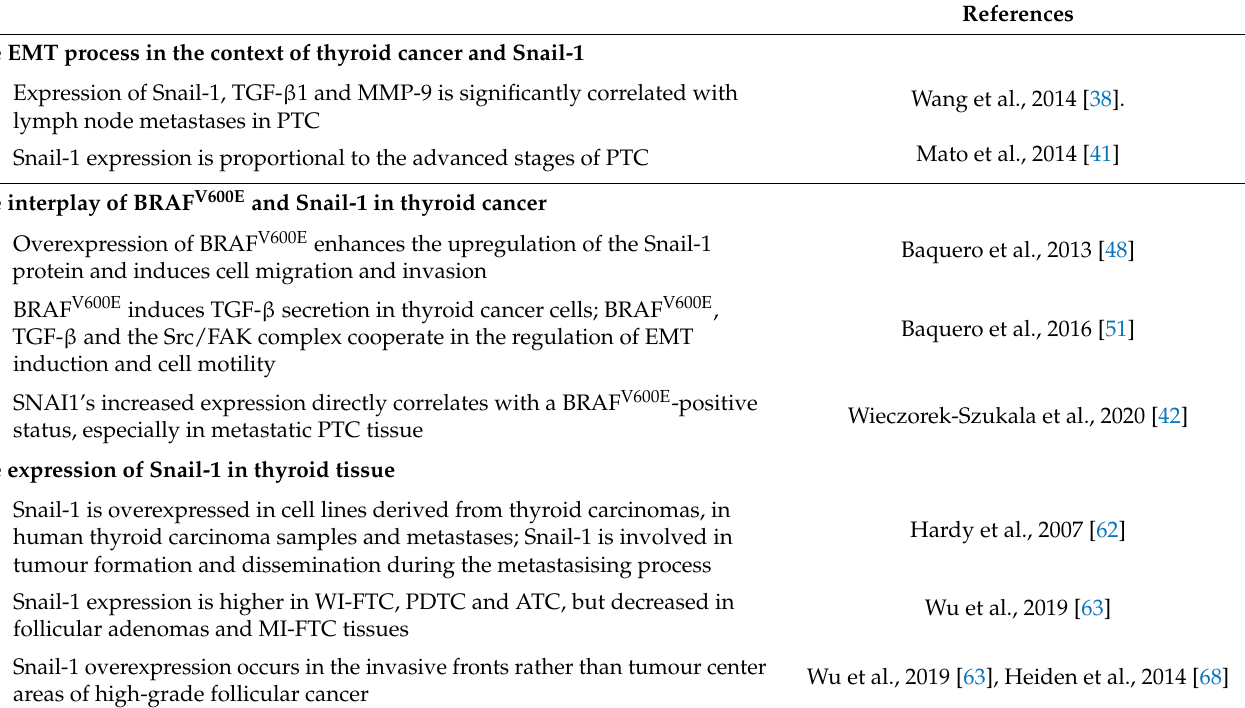
Table 2. Tabular overview of the most important information on the role of Snail-1 in cancerogenesis in thyroid